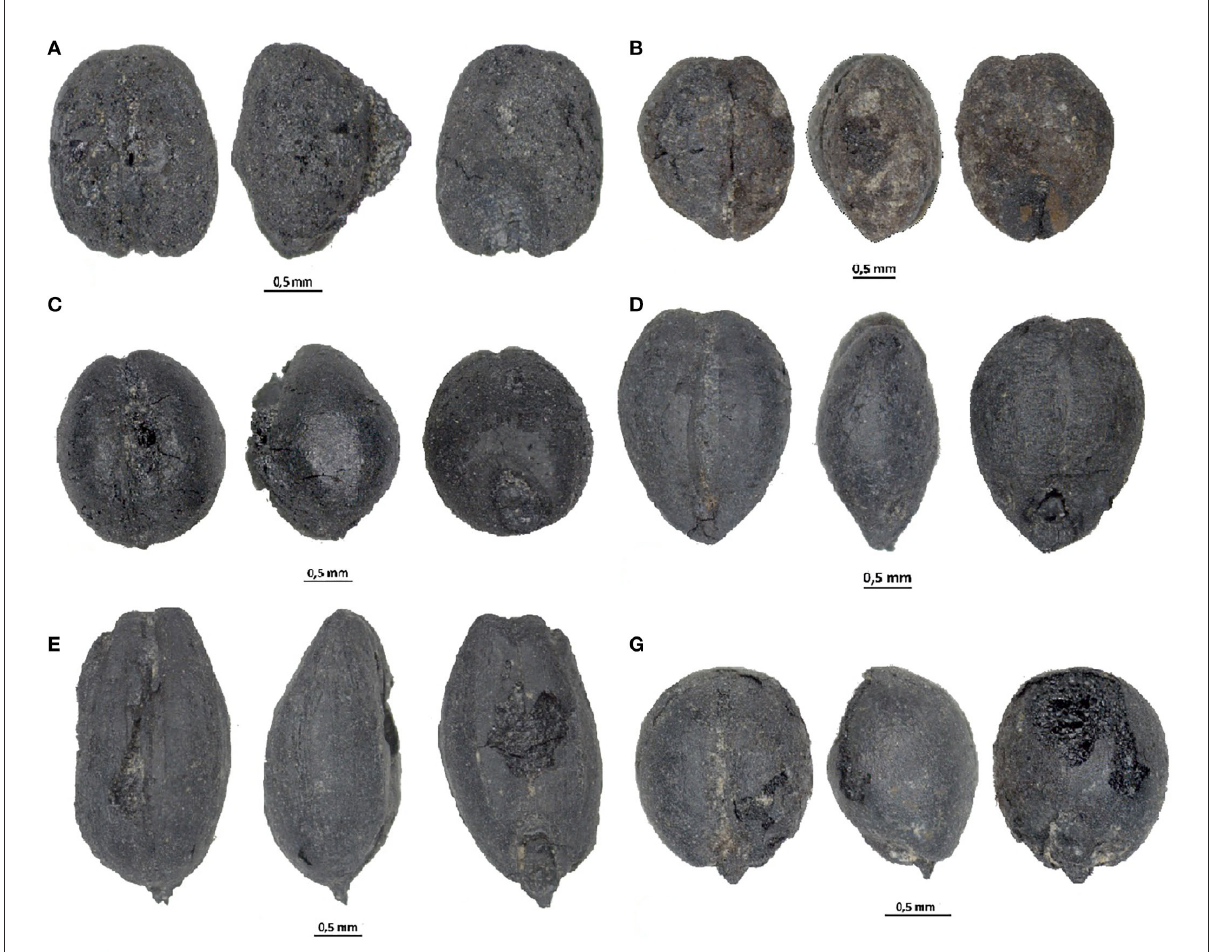
FIGURE3 Barley varieties from Chap II site: compact naked barley morphotypes ( Hordeum vulgare var. nudum ) (A–D,G) and hulled barley ( Hordeum vulgare var. vulgare ) (E)